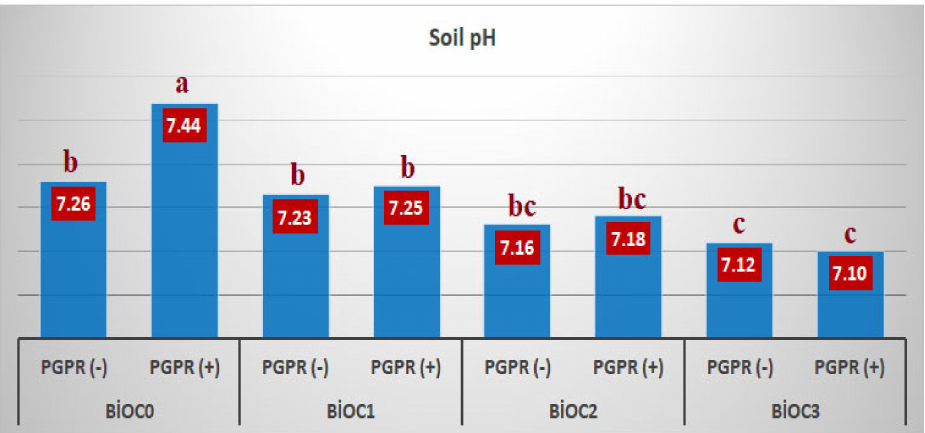
Figure 1. Effect of BxP interaction on soil pH: PGPR(+): Inoculation; PGPR(-): Non-inoculation; BioC 0 : 0% biochar; BioC 1 : 2.5% biochar; BioC 2 : 5% biochar; BioC 3 : 10% biochar; pH LSD(0.05) : 0.08. Means followed by different letters are statistically different from each other according to Duncan’s Multiple Range test at p ≤ 0.05.